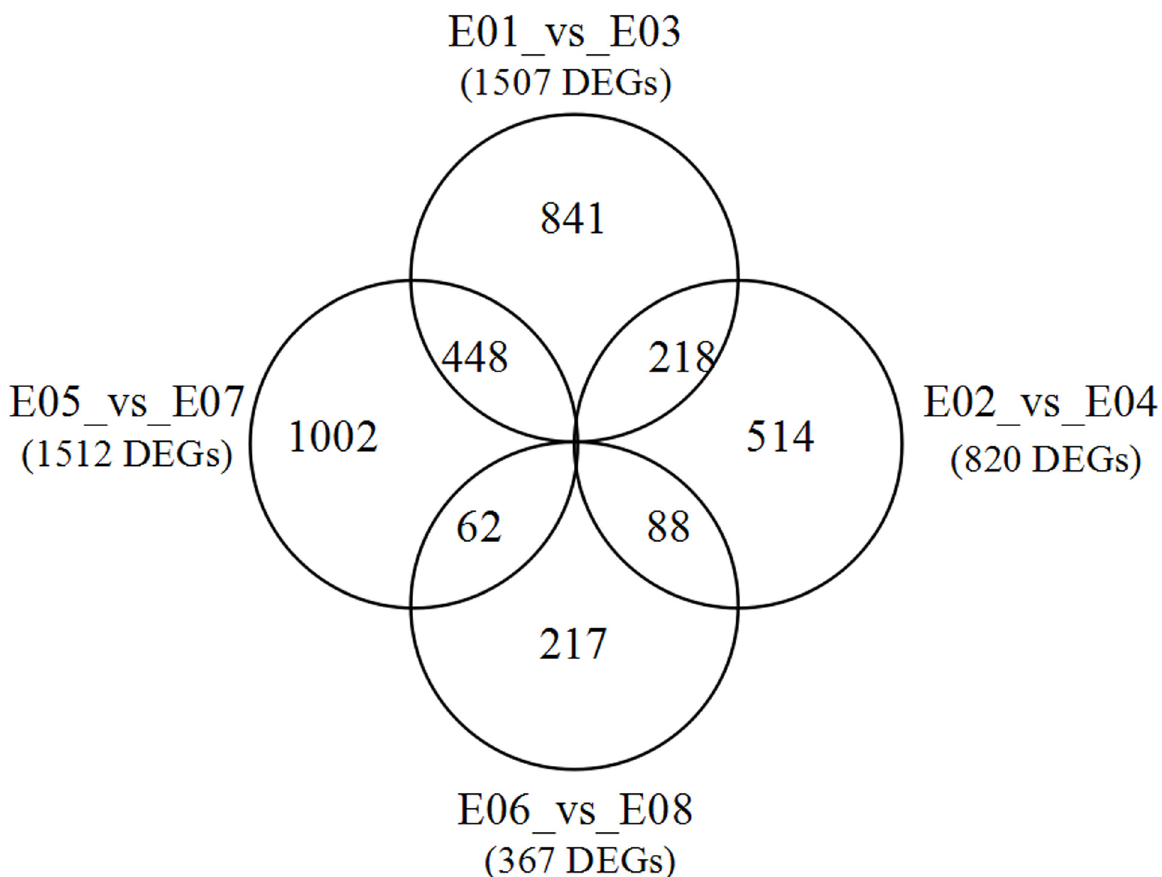
Fig 5. Venn diagram of genes differentially expressed in pair comparison of each